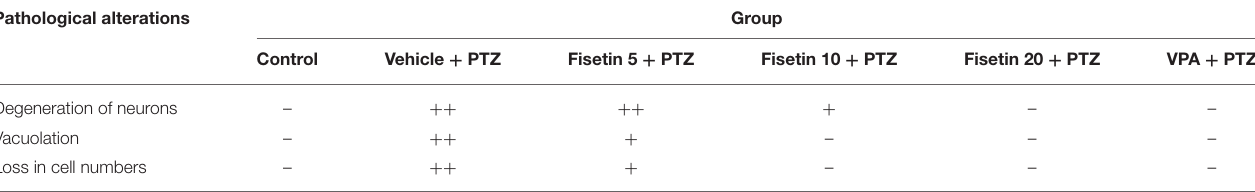
TABLE 3 | Effect of fisetin administration on histopathology of hippocampal CA1 region of experimental mice. Pathological